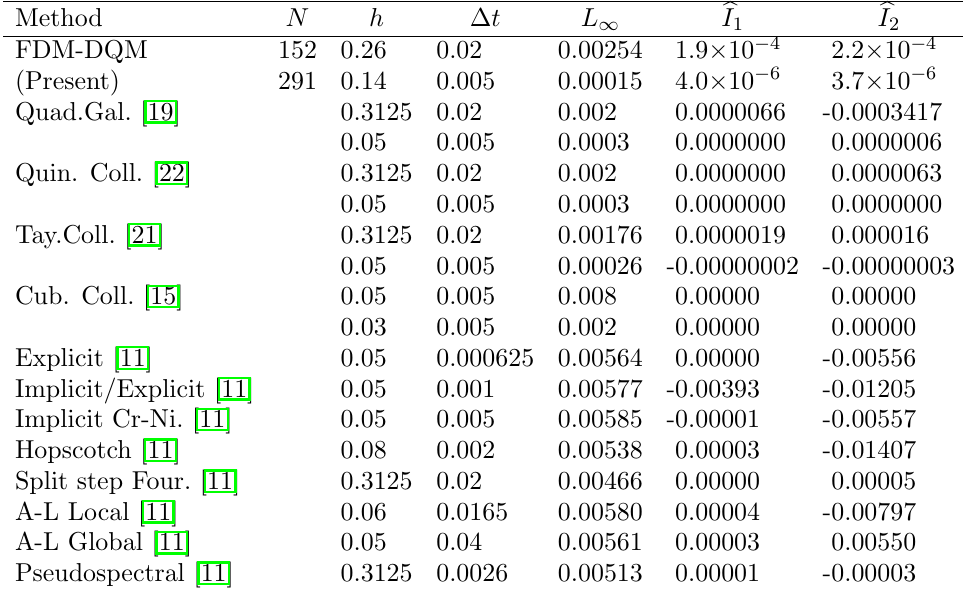
Table 3. L ∞ error norm and relative changes of invariants of single soliton: amp. = 1 , t = 1.